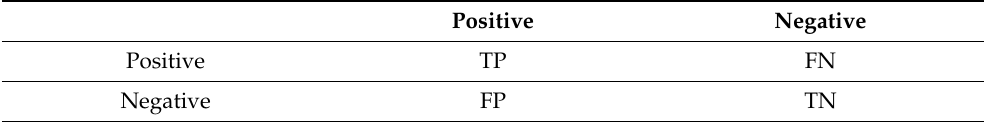
Table 2. Confusion matrix. For binary classification issues, the rows of the matrix represent the true values and the columns of the matrix represent the predicted values. TP (True Positive) means the number of positive samples predicted as positive samples, FN (False Negative) means the number of positive samples predicted as negative samples, FP (False Positive) means the number of negative samples predicted as positive samples, TN (True Negative) means the number of negative samples predicted as negative samples.